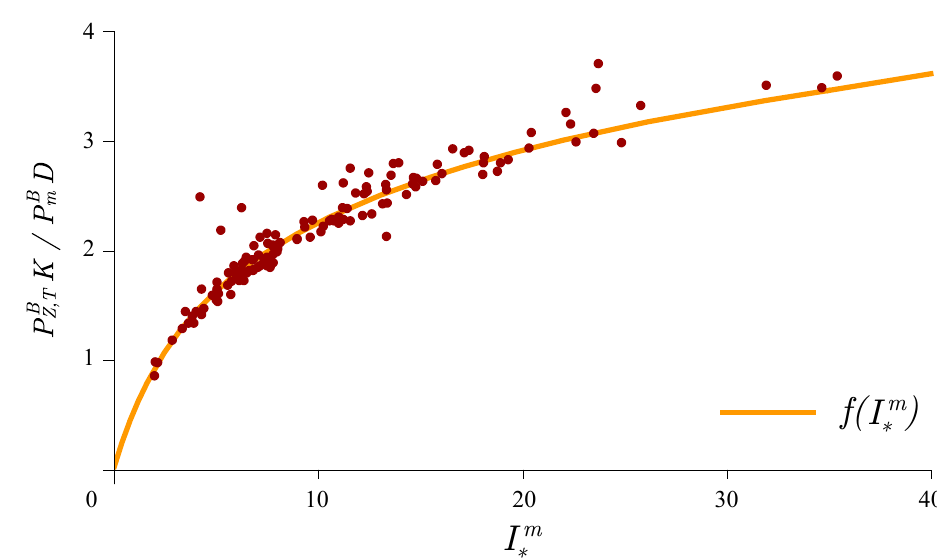
Figure 3. Comparison of the model and measured normalized daily watercolumn production obtained by combining the measured data with the estimated parameter values. The abscissa is the dimensionless irradiance, I m ∗ , and the ordinate is the ratio of normalized watercolumn production to P B m D / K . The continuous curve is the f ( I m ∗ ) function (10). The coordinates of each point are ( (cid:101) P B K / P B m D , α B (cid:101) I m / P B m ) , where α B and P B m are the estimated parameters for each profile. The r 2 Z , T (cid:101) 0 between the measured normalized watercolumn production and the modeled normalized watercolumn production is 0.97.